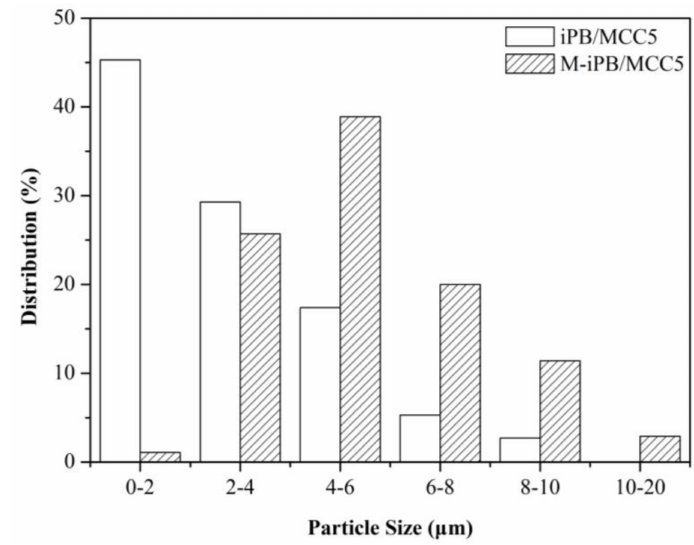
Figure 6. Particle size distribution of iPB/MCC composites.